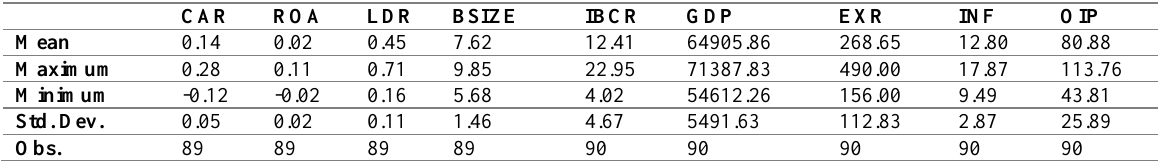
Table 2a: Statistical Description of the Variables